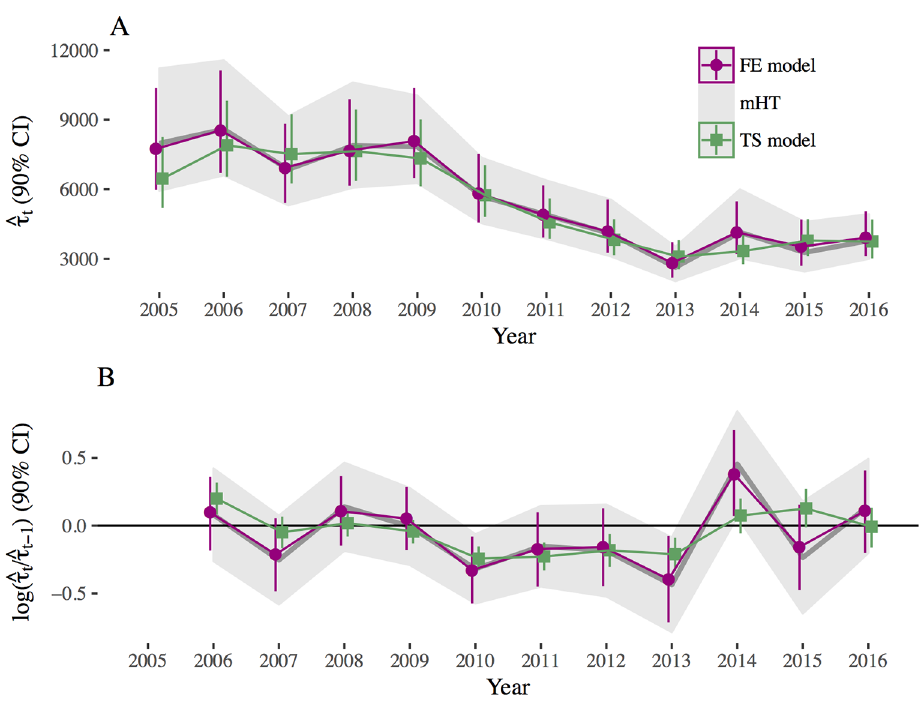
Fig 3. Population estimates by year. A: Population estimates ( ^ t ) by year t and B: the log rate of change of ^ t between years from the modified Horvitz-Thompson (mHT) approach (grey bands and lines), the fixed-effect, model-based approach (FE model), and the temporal model-based approach (TS model). Error bars are 90% confidence intervals for mHT and 90% credible intervals for the TS and FE models.